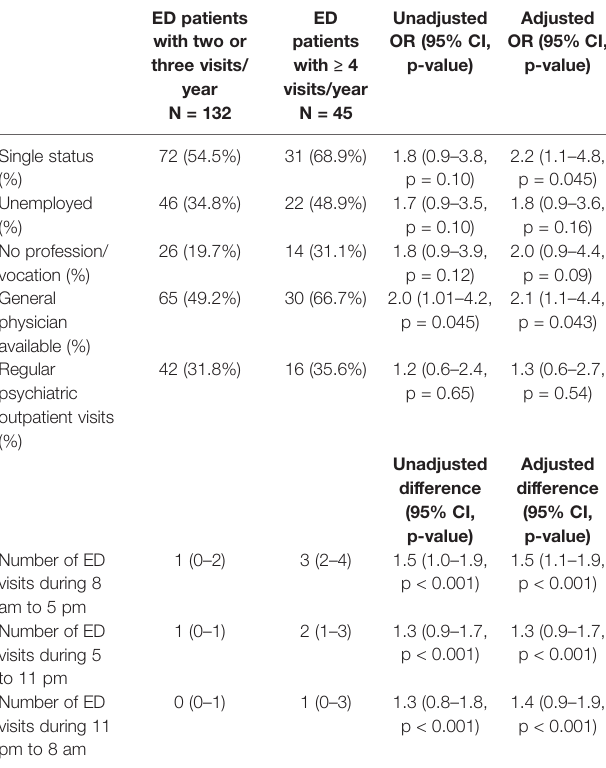
TABLE 5 | Differences and risks for recurrent emergency department (ED)